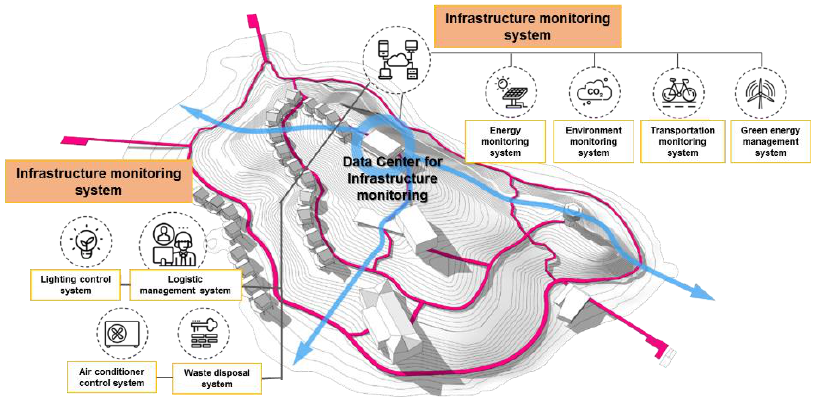
Figure 3. Smart infrastructure in Huangguan.